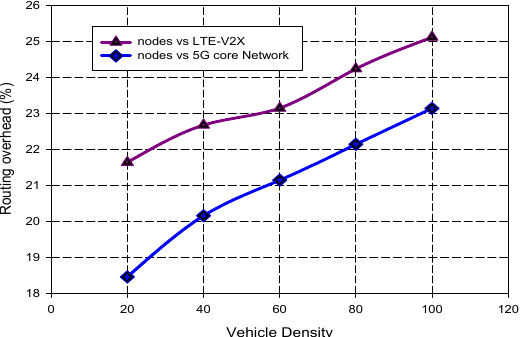
Figure 6. Routing overhead of packet dissemination over 5G V2X networks versus vehicle